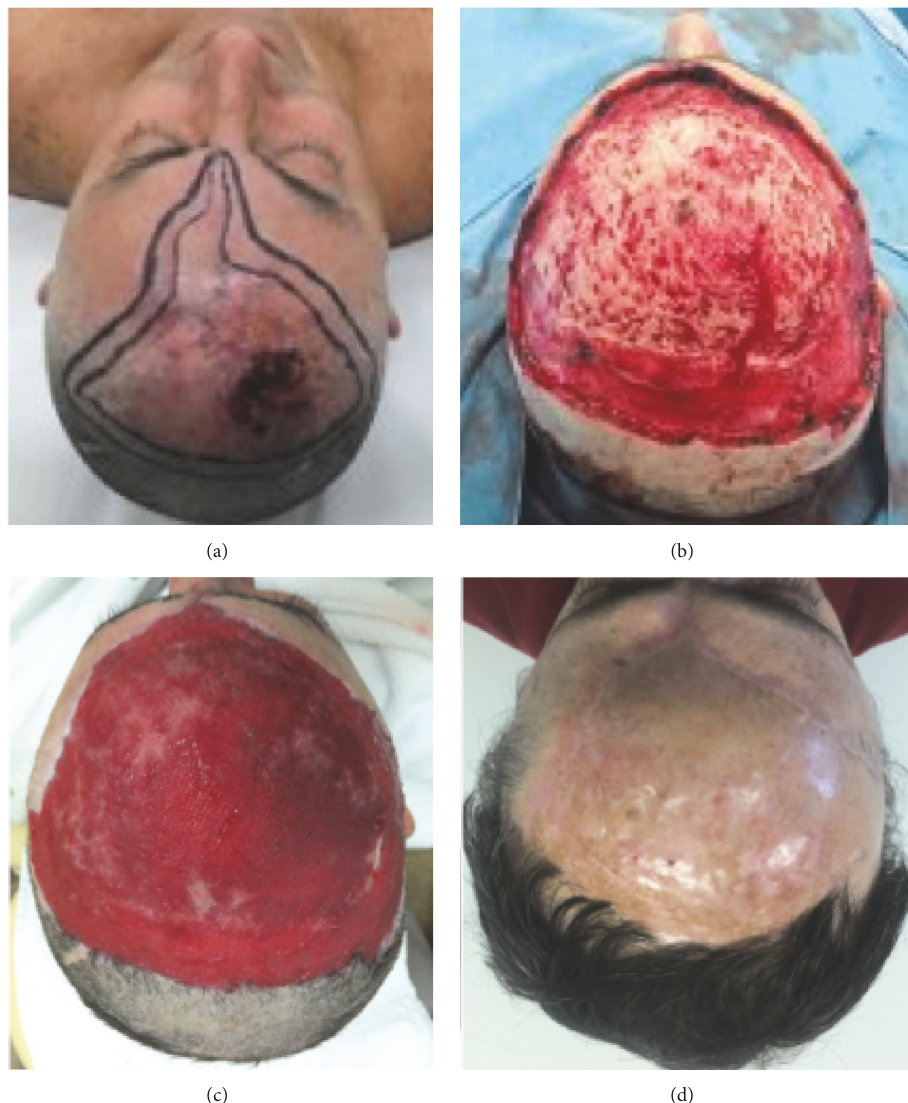
Figure 3: (a) Basal cell carcinoma, clinical aspect before surgery; (b) once again, periosteal removal was necessary; (c) granulation tissue (negative pressure wound therapy was used); (d) late postoperative